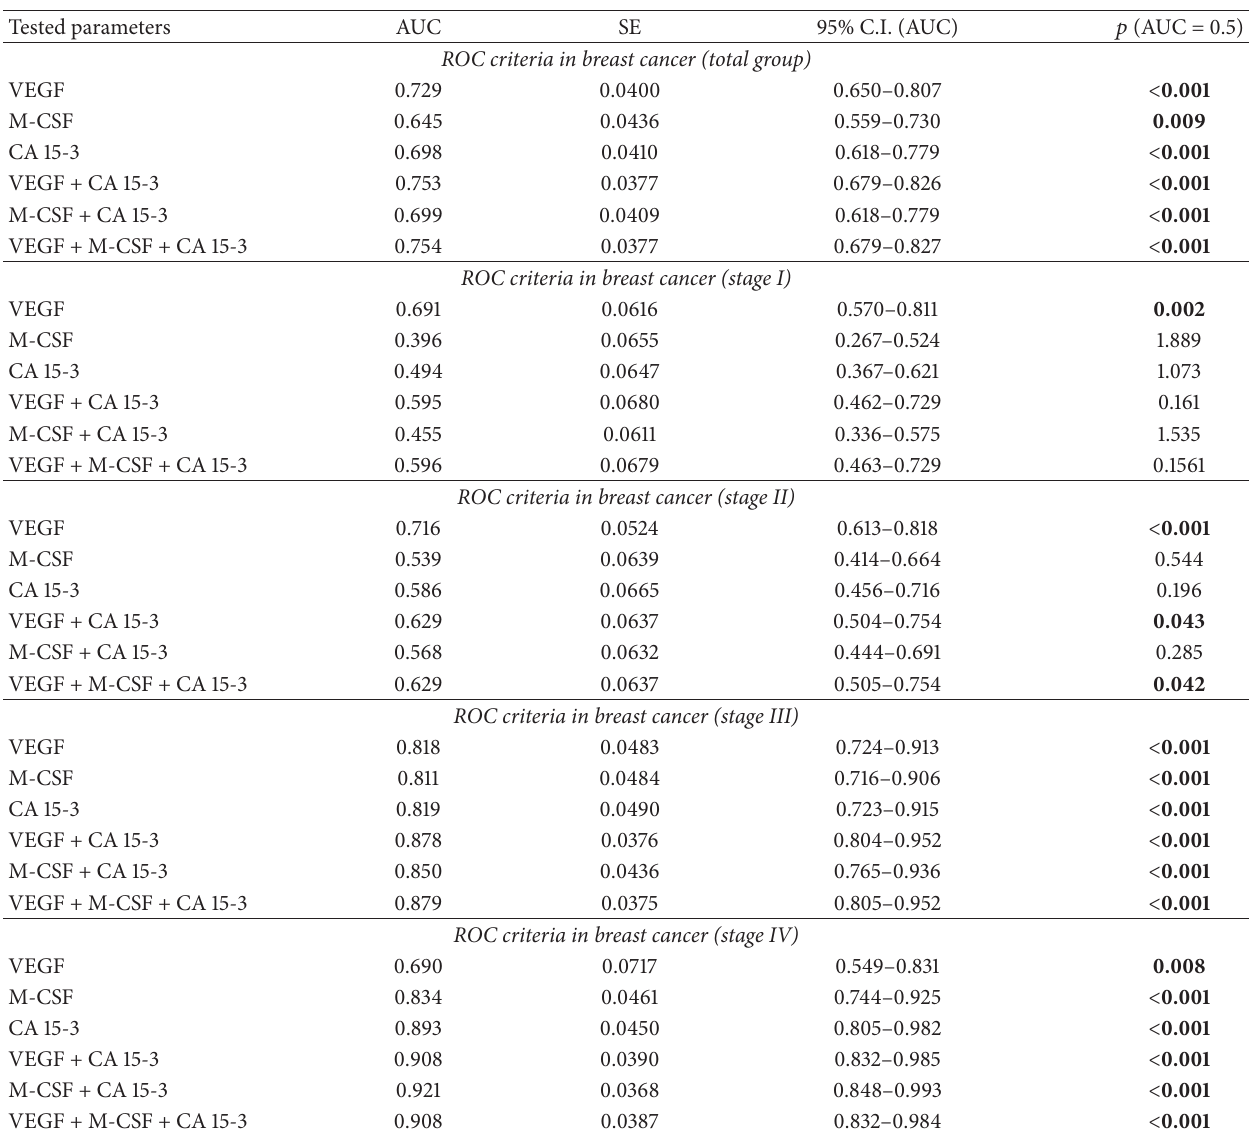
Table 3: Diagnostic criteria of ROC curve for tested parameters and CA